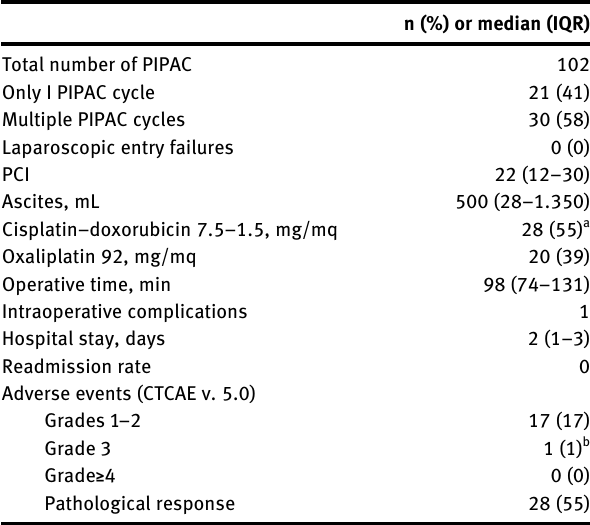
Table  : Operative and postoperative PIPAC-related